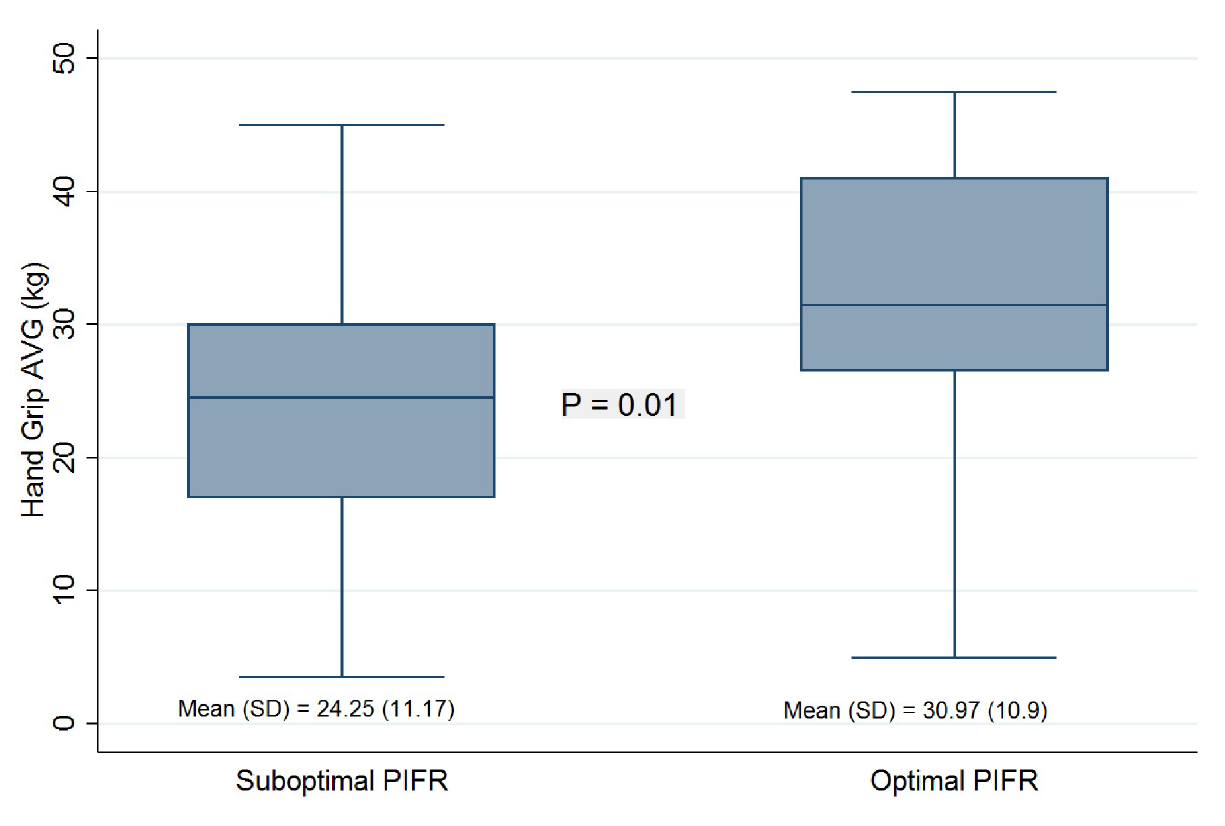
Fig 1. Association between peak inspiratory flow rate (PIFR) and Hand grip strength (HGS). The middle line in the box is the median HGS, the upper and lower boundaries of the box represent 75 th and 25 th percentiles of HGS distribution, the whiskers are 1.5 � IQR from 75 th and 25 th percentiles from HGS.